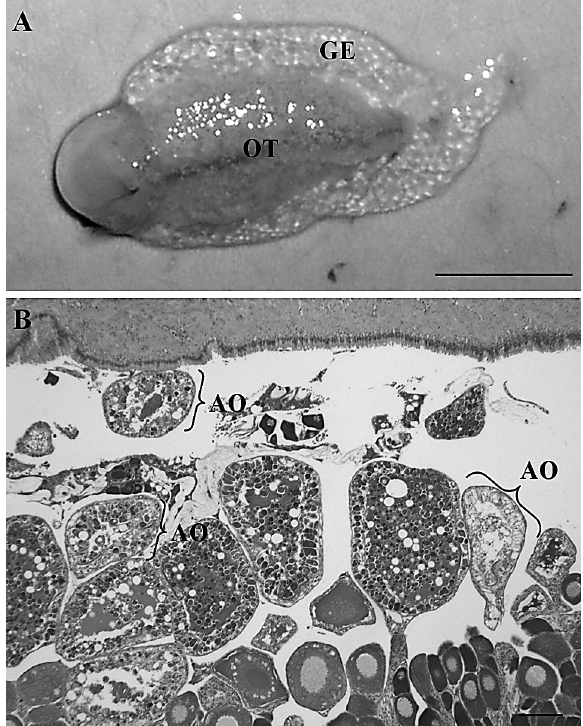
Fig . 8. – A, lionfish ovary with unreleased gelatinous egg mass (scale bar = 10 mm). Anterior end of the ovary is oriented to the left. B, oocytes in several stages of ovarian atresia. The most advanced- staged atretic oocytes are labeled as AO (scale bar = 100 µm). GE, gelatinous egg mass; OT, ovigerous